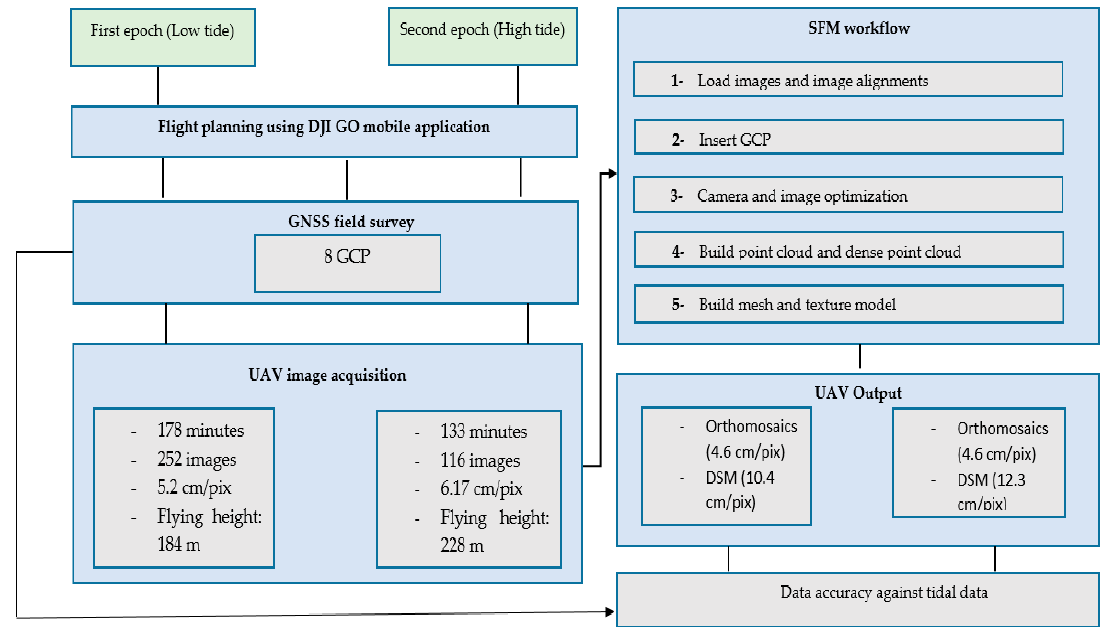
Figure 5. General overview of methods from flight planning to accuracy assessment of the digital surface model (DSM) with tidal data.